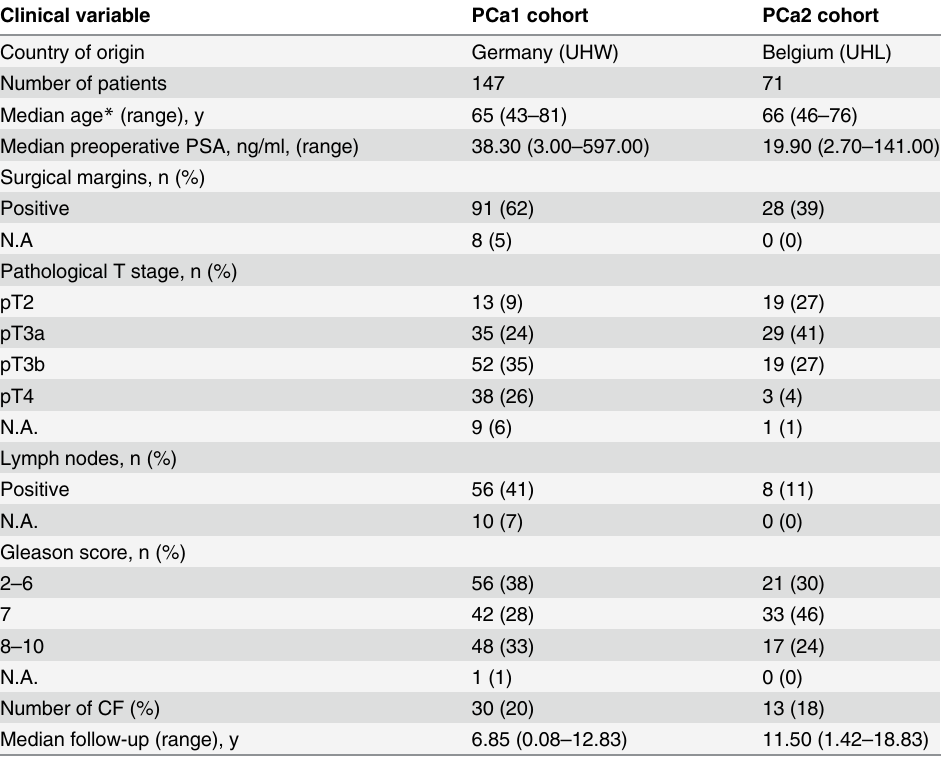
Table 1. Clinico-pathological characteristics of the